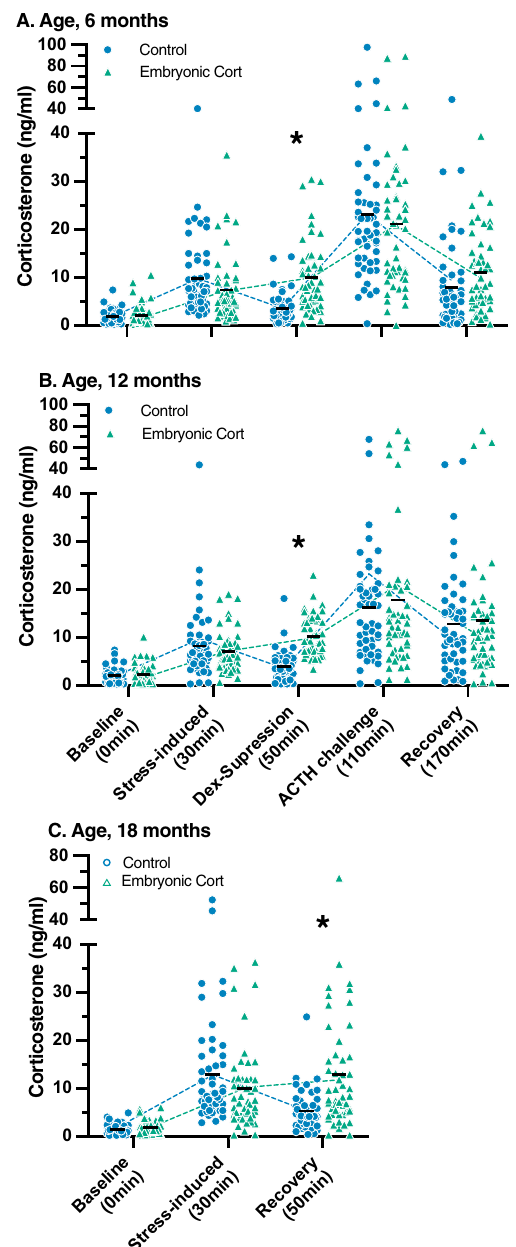
Figure 2. Corticosterone concentrations for each component of the five-point HPA challenge at ( A ) 6 months and ( B ) 12 months, and the reduced three-point HPA challenge at ( C ) 18 months. All control (blue circle) and 5 ng embryonic corticosterone (green triangle) individuals are represented. Black dashes represent group means and are connected by dashed lines for each treatment. Points are jittered for clarity of illustration. Differences between treatments at the same HPA challenge timepoint are marked with an asterisk (Tukey HSD < 0.05). Because the majority of corticosterone values fell between 0 and 40 ng/ml, we split the y-axis at 40 ng/ml to more easily see the values between 0 and 40